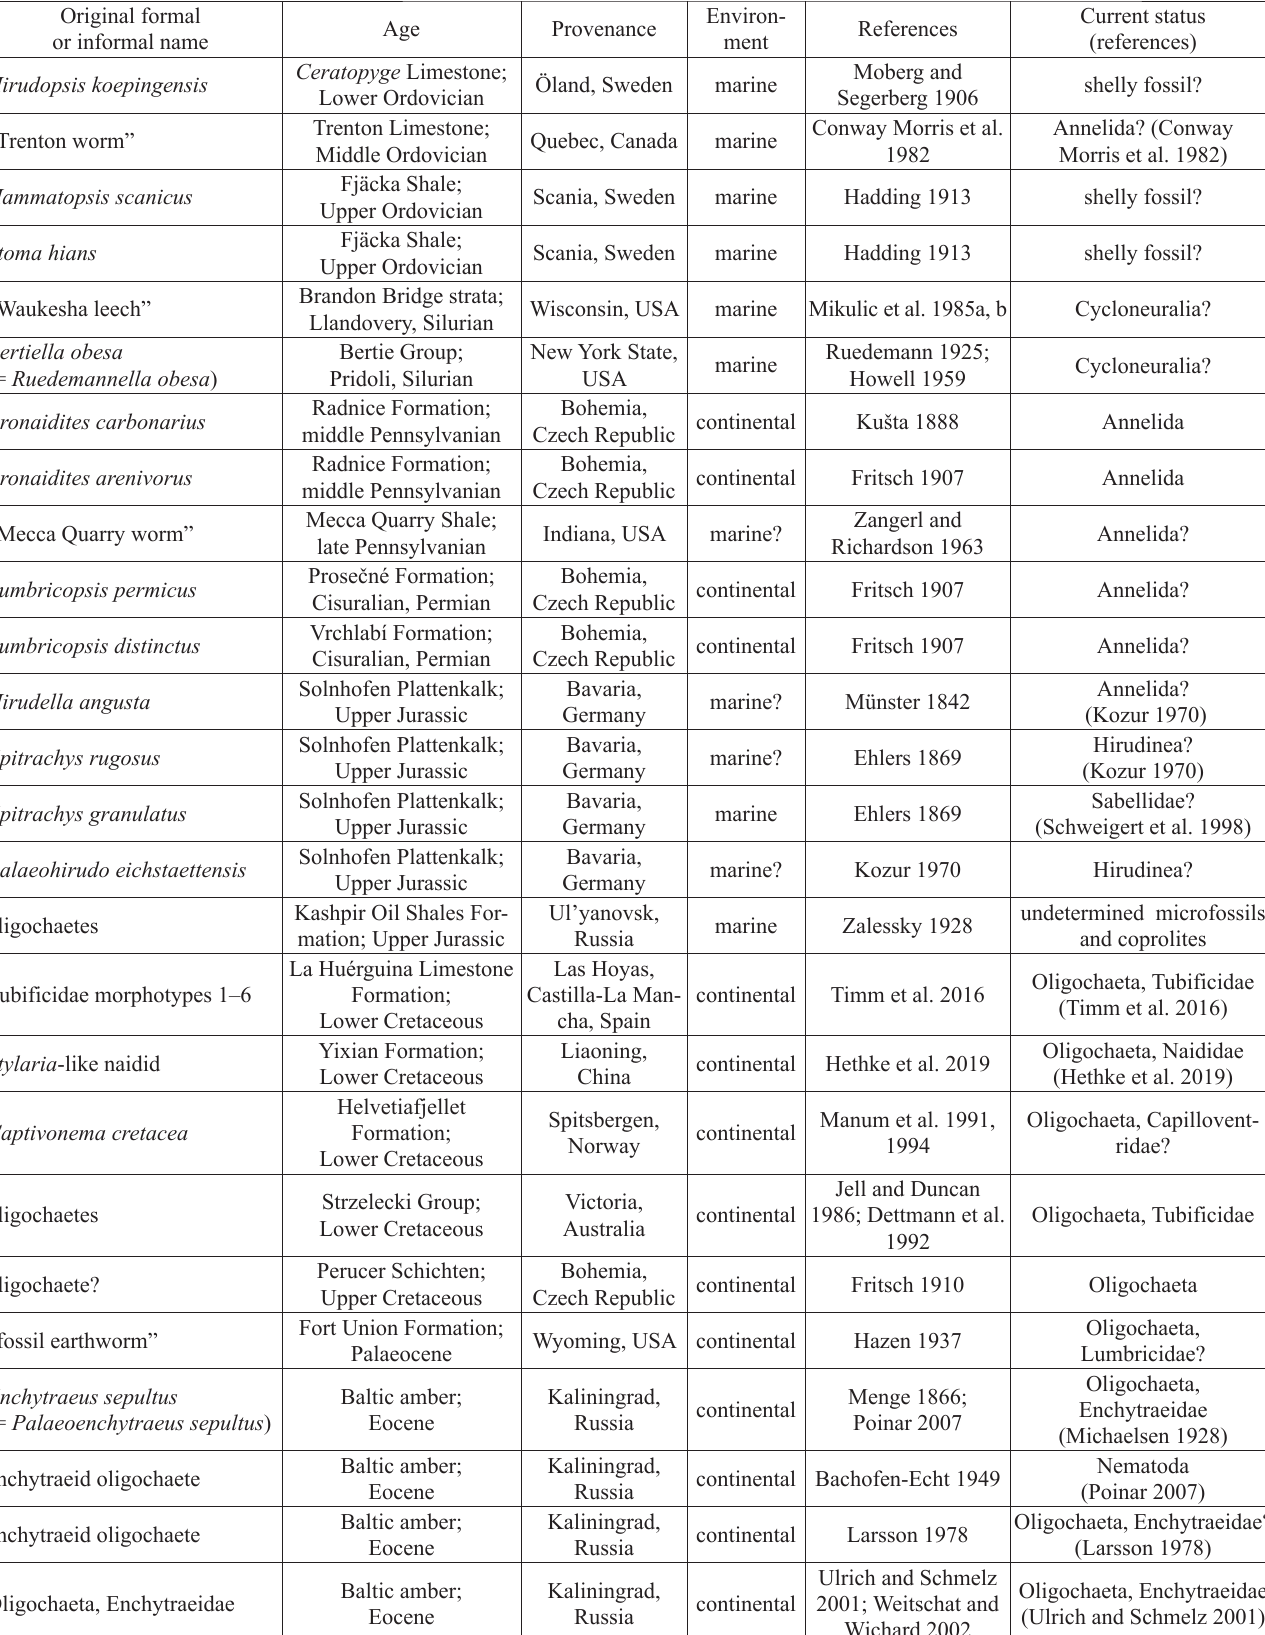
Table 1. Possible body fossil clitellates and their reinterpretation. Distinct trace fossils and cycloneuralian palaeoscolecidans are not included. Original